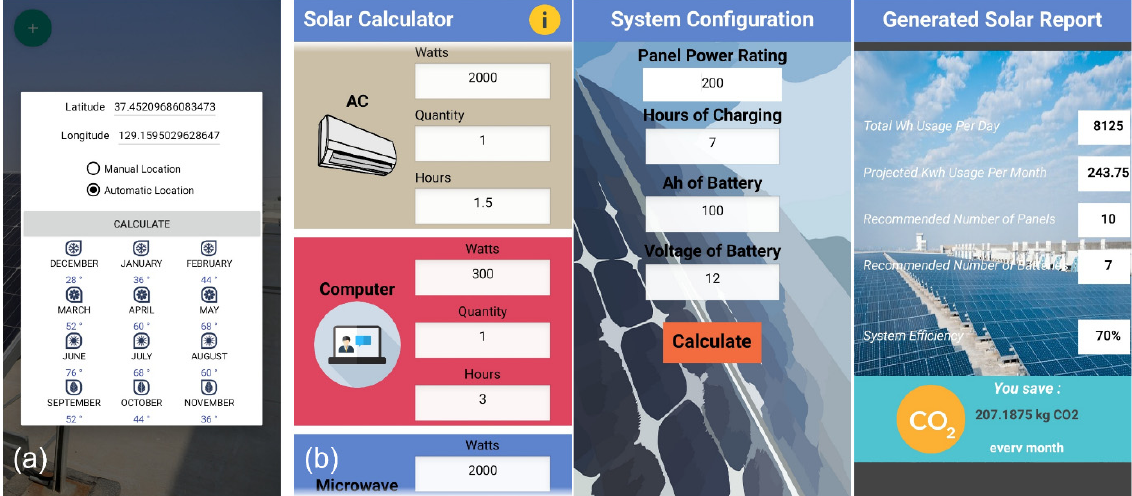
Figure 2. Representative smartphone applications for the module optimization. ( a ) Calculation of optimal module tilt (Seasonal PV Tilt Angles app), ( b ) PV system configuration and report by electrical load (Solar Calculator app).